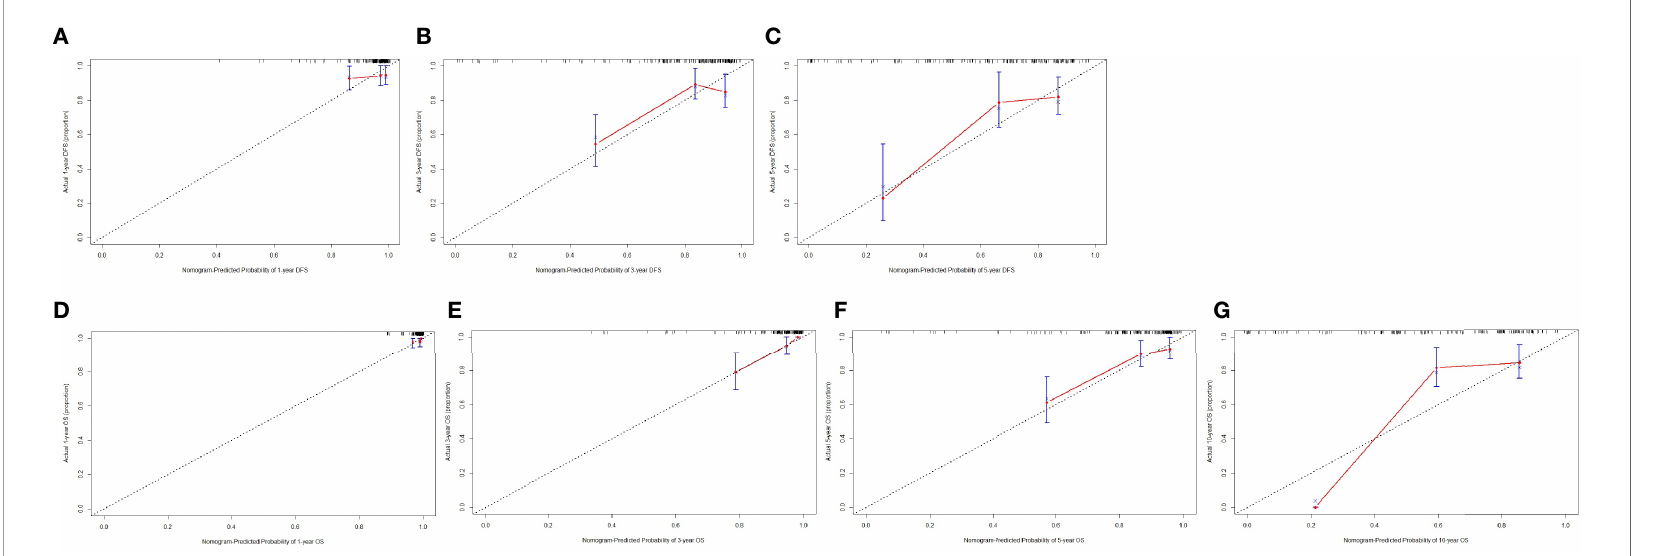
FIGURE 3 | The calibration curves for predicting the 1-, 3-, and 5-year DFS rates and 1-, 3-, 5-, and 10-year OS rates. The X-axis presents the nomogram-predicted probability of disease-free survival (DFS) and overall survival (OS), and the Y-axis shows the actual DFS and OS. (A) The calibration curves for predicting the 1-year DFS rate in patients with breast cancer. (B) The calibration curves for predicting the 3-year DFS rate in patients with breast cancer. (C) The calibration curves for predicting the 5-year DFS rate in patients with breast cancer. (D) The calibration curves for predicting the 1-year OS rate in patients with breast cancer. (E) The calibration curves for predicting the 3-year OS rate in patients with breast cancer. (F) The calibration curves for predicting the 5-year OS rate in patients with breast cancer. (G) The calibration curves for predicting the 10-year OS rate in patients with breast